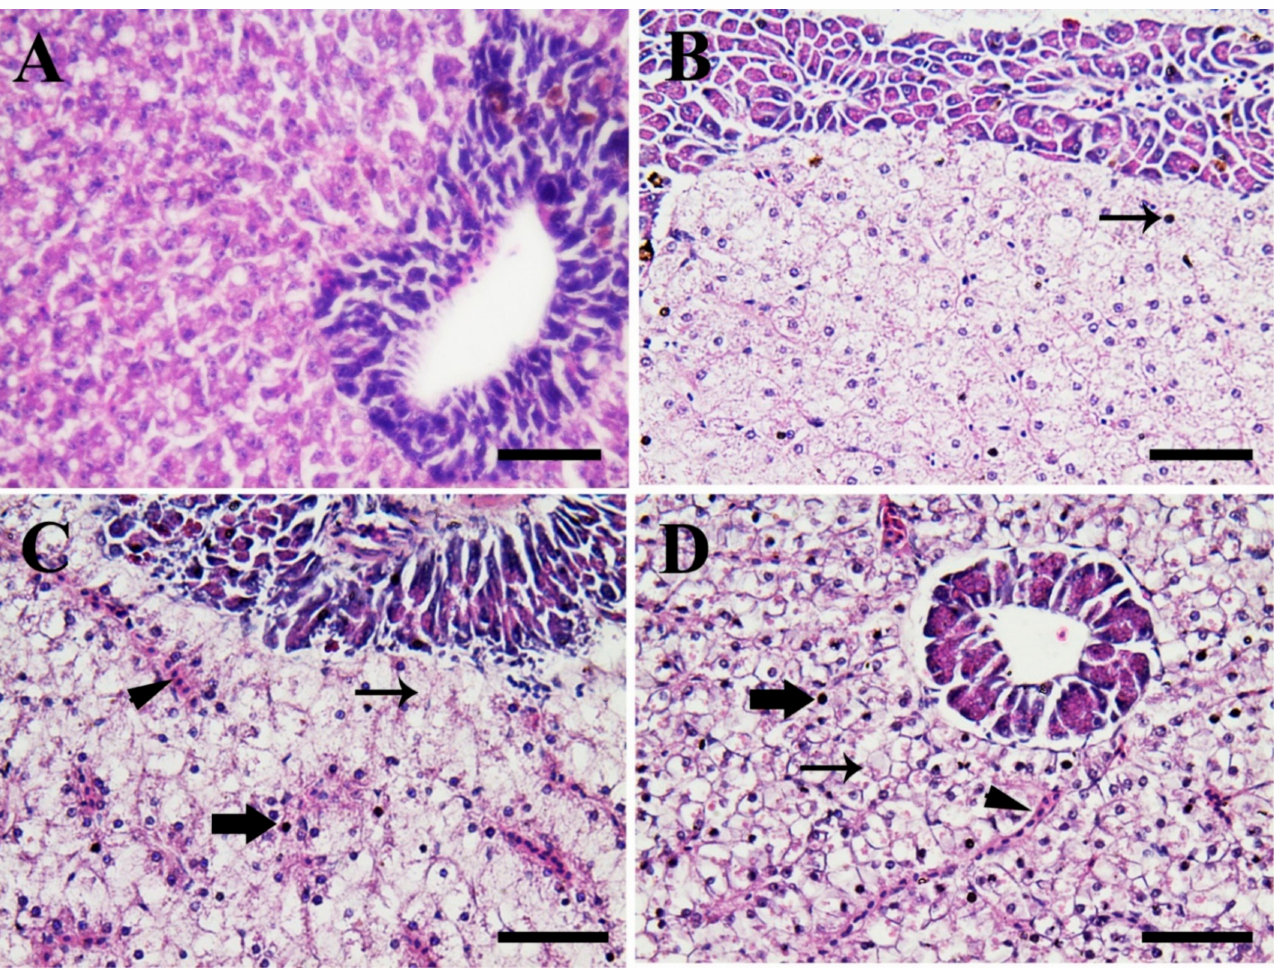
Figure 6. Illustrative photomicrographs of the hepatopancreatic tissues of Nile tilapia (hematoxylin and eosin (H & E) stain, scale bar = 50 µ m) from the control group ( A ), and the fish groups exposed to SiO 2 NPs at 20 mg/L ( B ), 40 mg/L ( C ) and 100 mg/L ( D ), respectively, for 3 weeks. ( A ) Normal hepatopancreatic architecture, hepatic cord, and acini of the exocrine pancreas. ( B ) Slight fatty vacuolized and necrotic hepatocytes (arrow). ( C ) Moderate congestion (arrowhead), diffuse fatty vacuolized hepatocytes (thin arrow), moderate necrosis (thick arrow), and mononuclear inflammatory cell infiltrations in the pancreatic acinar cells. ( D ) Severe necrosis (thick arrow), fatty degeneration of hepatocytes (thin arrow), and severe congestion of the blood sinusoids